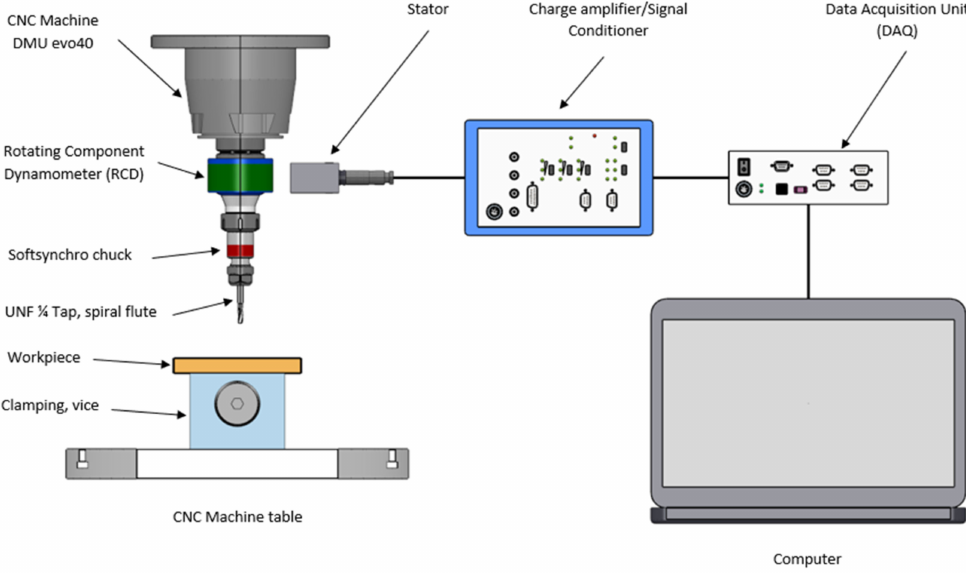
Figure 4. Experimental set up with instrumentation on CNC machine